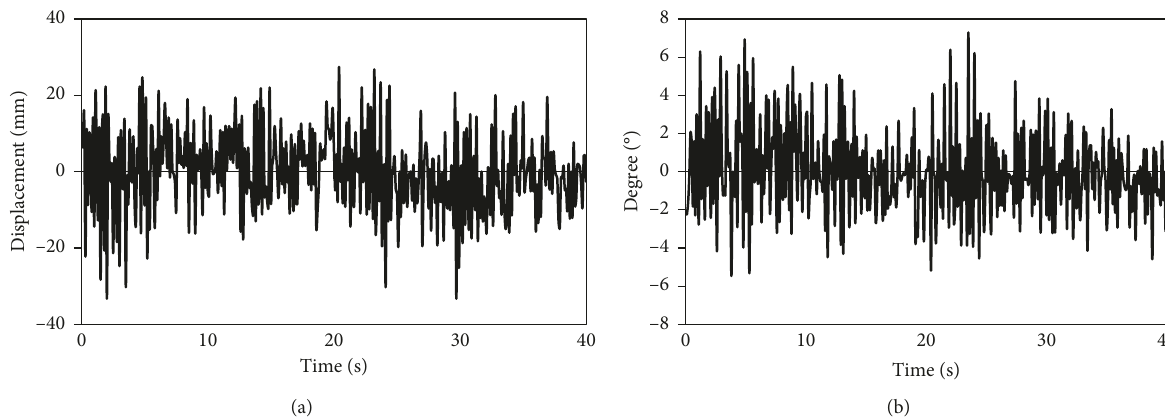
Figure 7: Time history responses for CM2, θ � 30 ° , 1.0(D), at 15m/s: (a) vertical vibration; (b) torsional vibration.